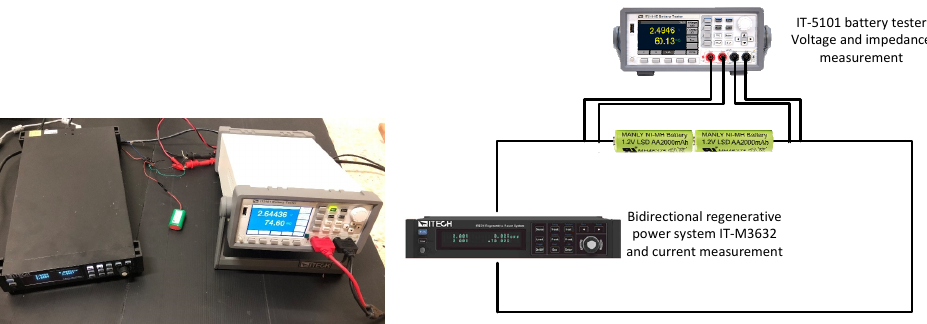
Figure 4. Experimental setup used for battery charge–discharge cycle tests.